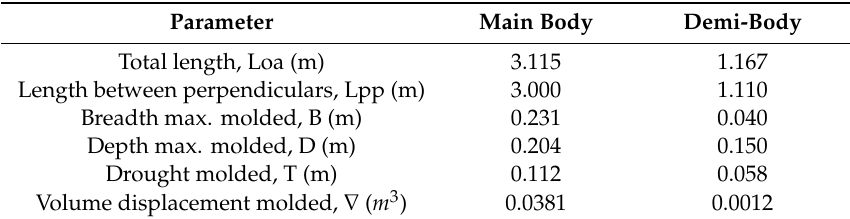
Table 1. Main parameters used for the trimaran model.